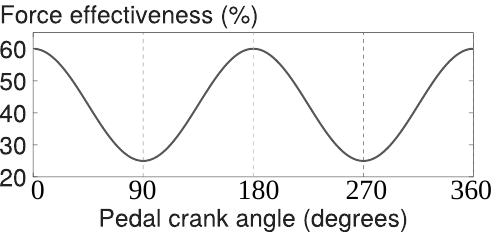
Figure 5. Human force effectiveness versus pedal crank angle